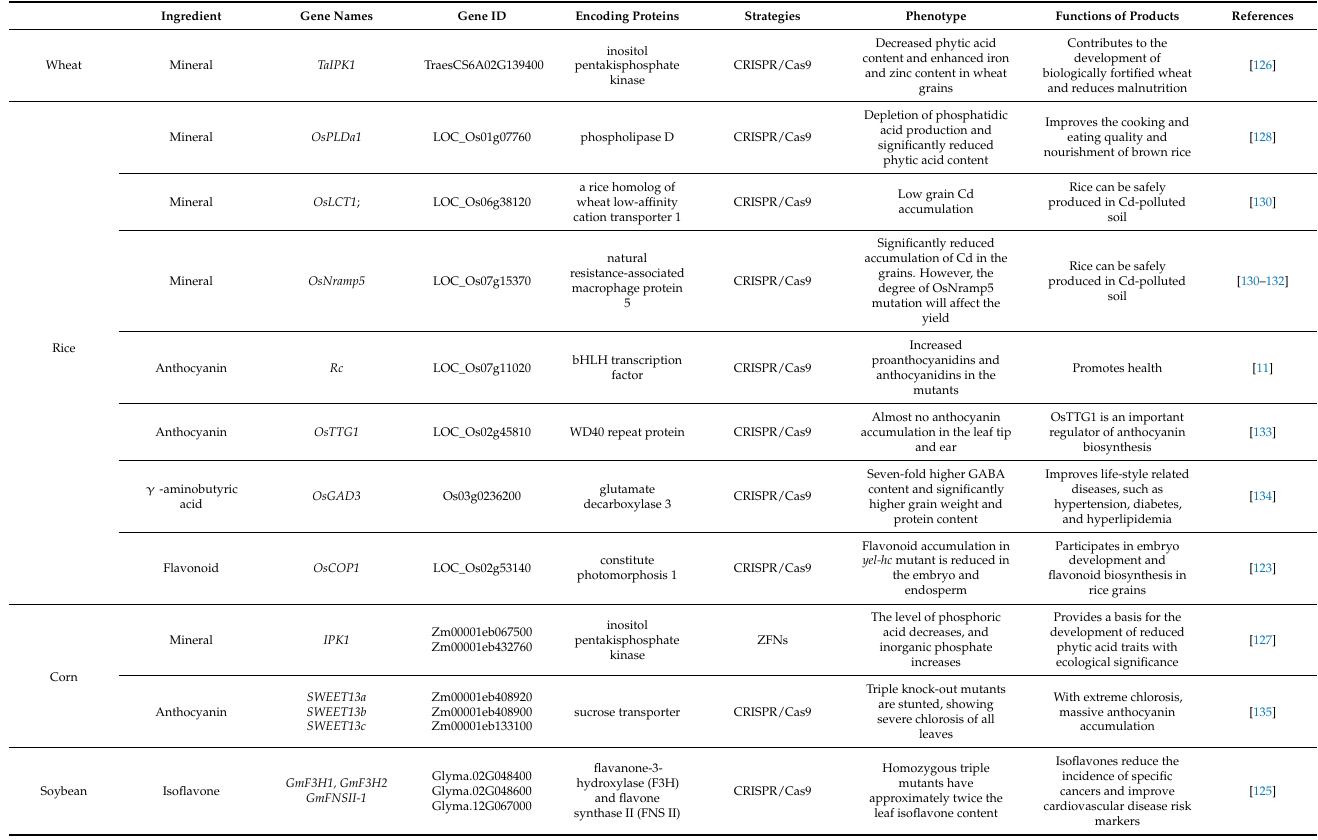
Table 4. List of gene resources of other health functional components in rice, wheat, corn, and soybean improved by gene